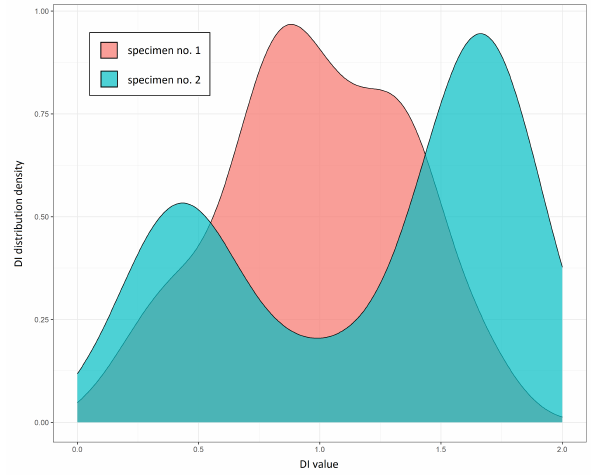
Figure 8. Distribution of corr damage index for the two specimens at a temperature above 60 ◦ C without damage